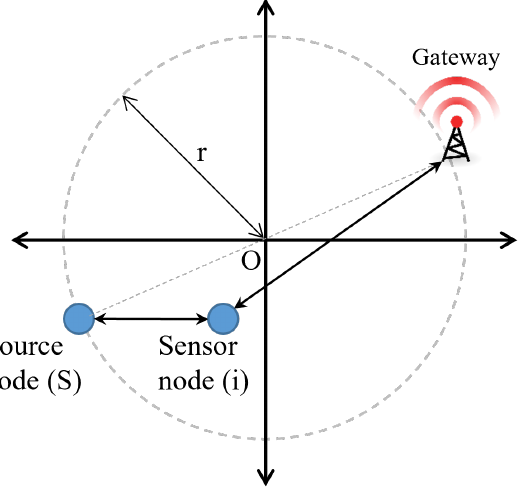
Figure 4. The forwarding zone between a sensor node (S) and the gateway